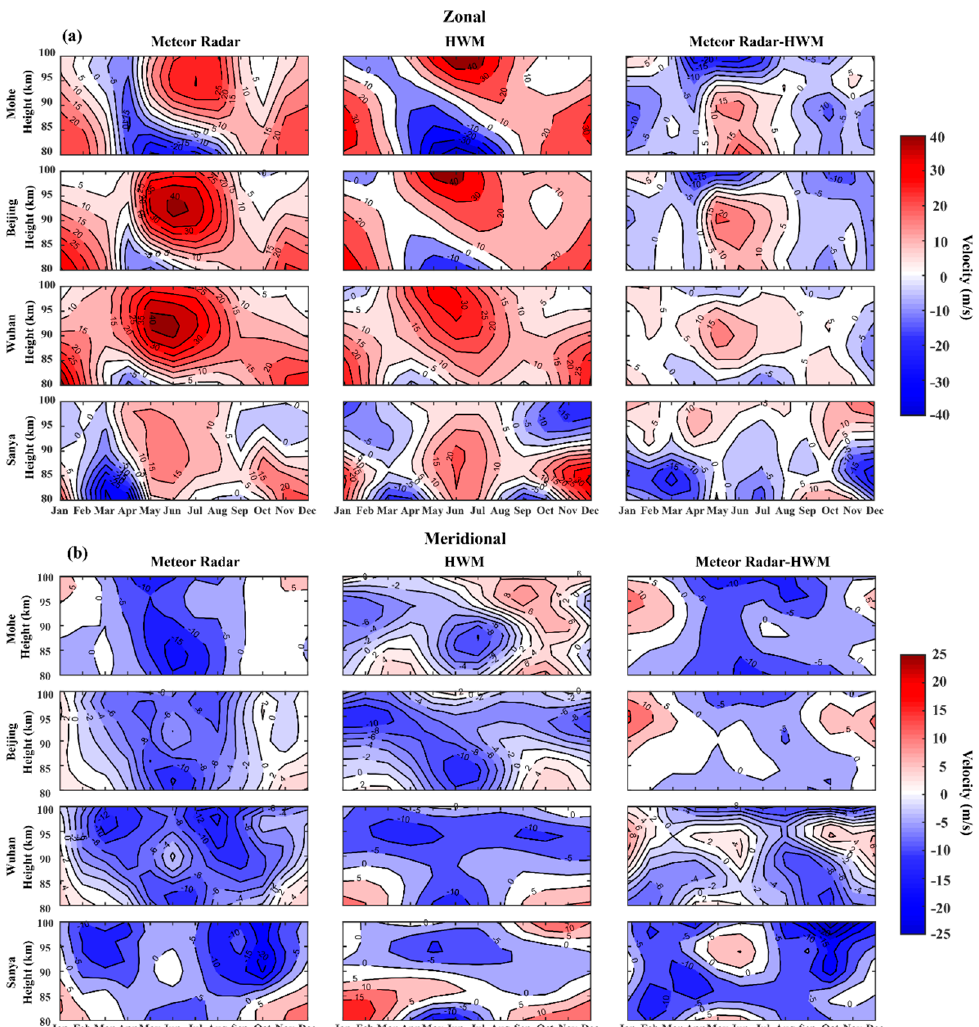
Figure 2. Comparison of the monthly mean zonal ( a ) and meridional ( b ) wind in the composite year between meteor radar (left column) and Horizontal Wind Model (HWM14) (middle column). The right column is the difference between radar measurement and model prediction.